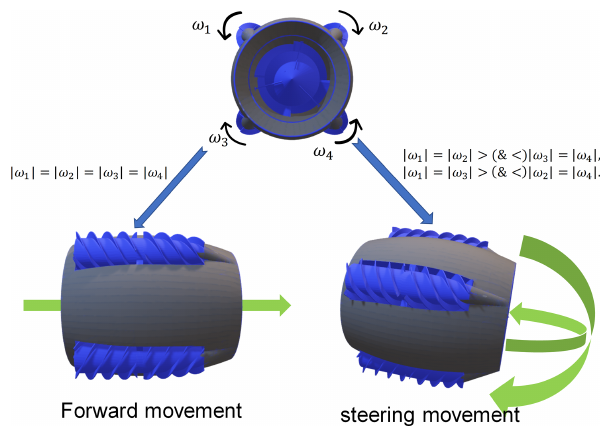
Figure 1. Schematic diagram of motion direction of